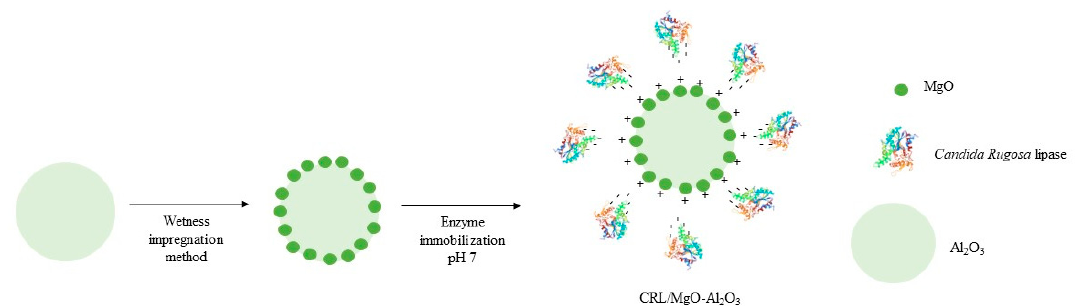
Figure 14. The mechanisms of CRL adsorption on MgO-Al 2 O 3 at pH 7.